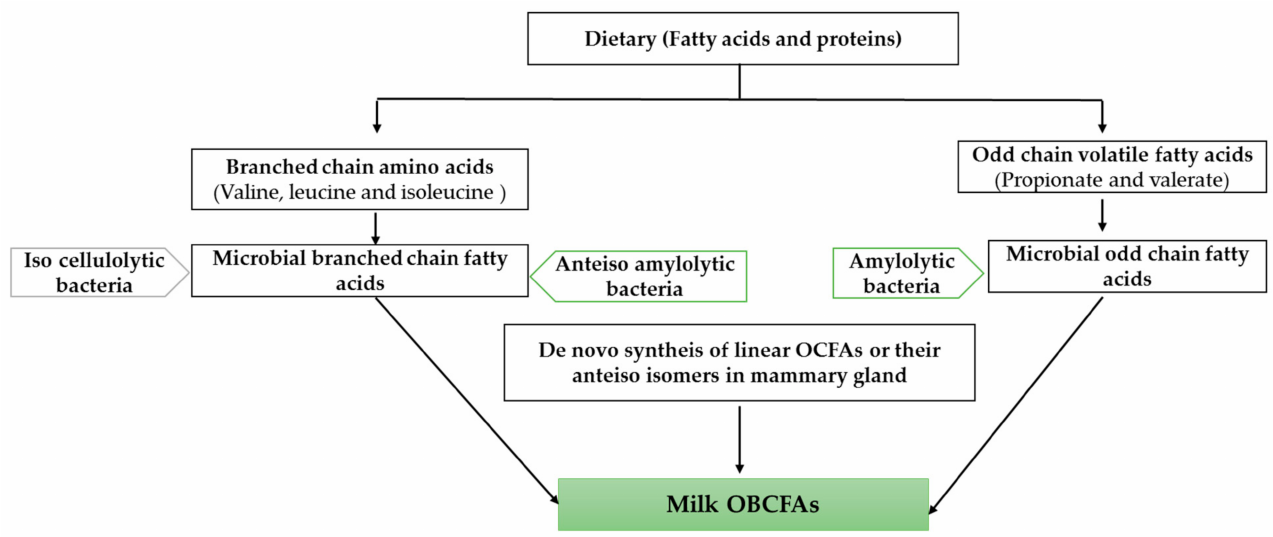
Figure 1. Origin of milk odd and branched chain fatty